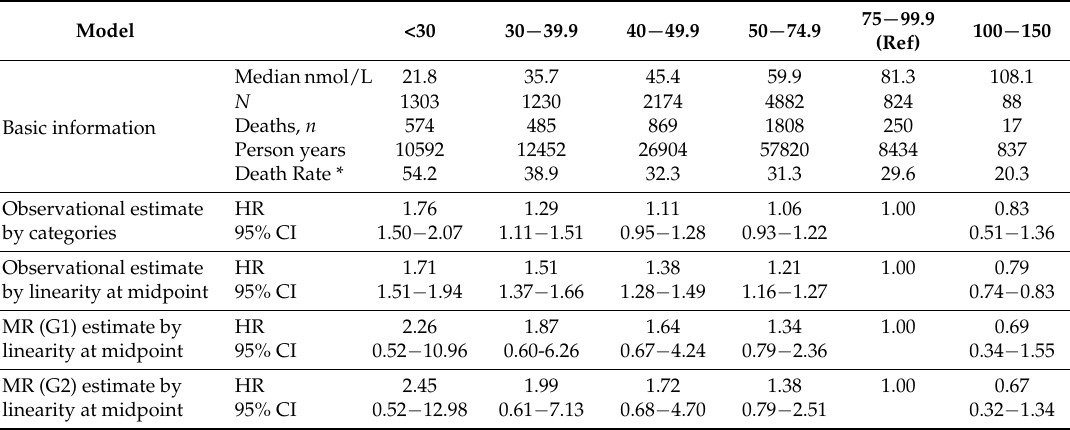
Table 3. HR of mortality by categories of 25-hydroxyvitamin D (25(OH)D, nmol/L), and estimates by categories assuming linearity for observational and MR